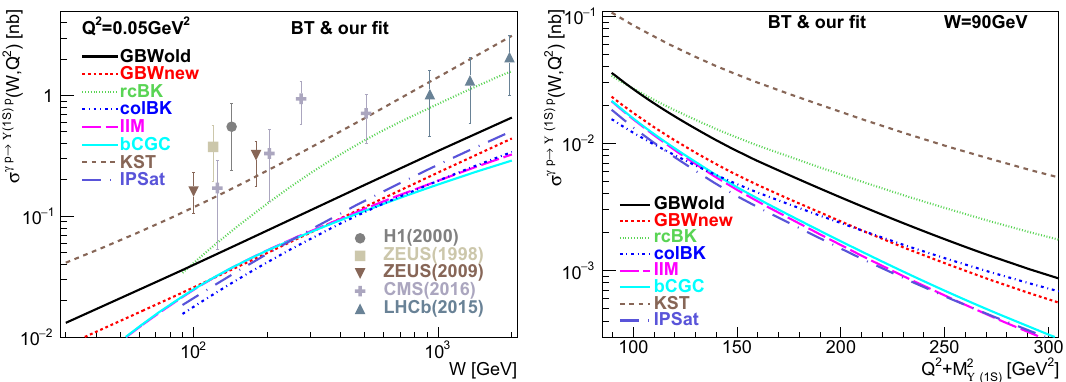
Fig. 15 The same as Fig. 8 but for different phenomenological dipole cross sections described in Sect. 4